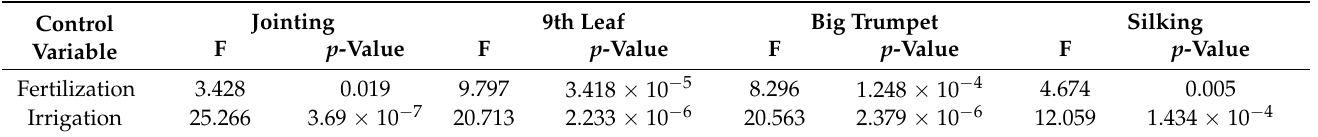
Table 3. ANOVA results between LAI and control variables in 2020.